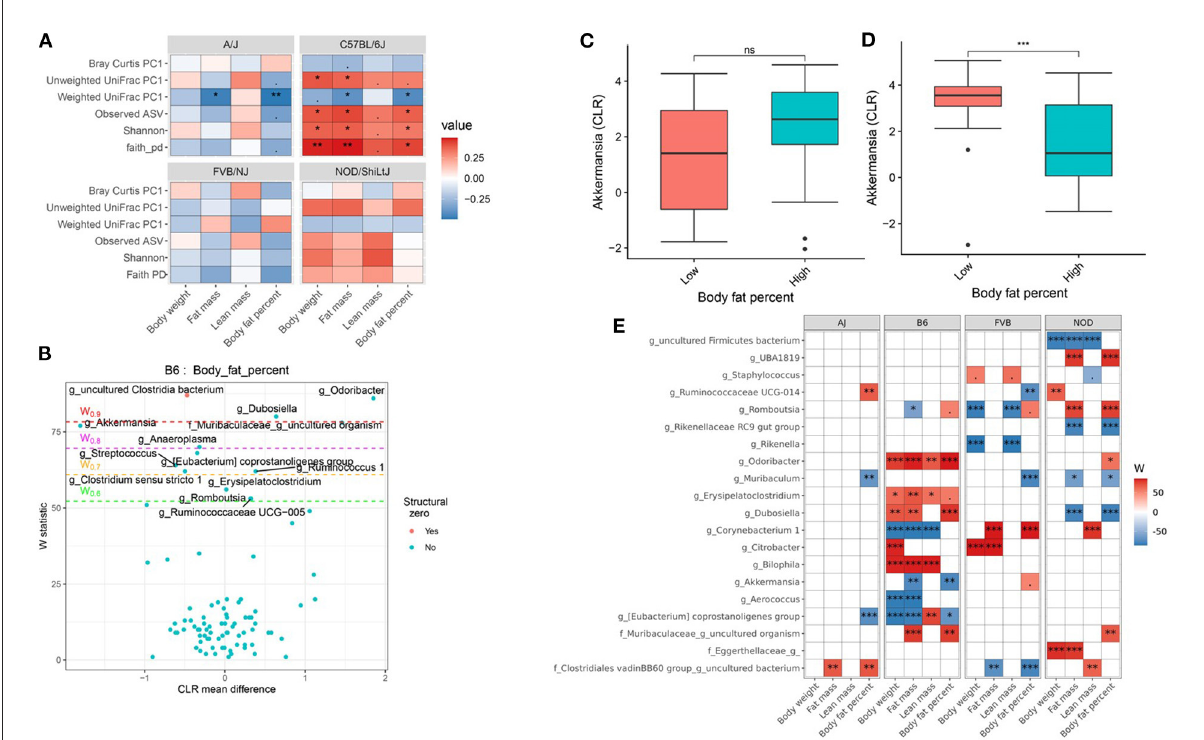
FIGURE5 Host genetics and gut microbiota interact to modulate host body composition. (A) Association between body composition measures and α -diversity or first principal component (PC1) of β -diversity measured by mouse strains determined by using Spearman correlation. As indicated, red represents a positive correlation and blue represents a negative correlation. “***” = adj. p < 0.001, “**” = adj. p < 0.01, “*” = adj. p < 0.05, “.” = adj. p < 0.10, and “ns” = not significant. (B) Volcano plot of the differential genera abundance between C57BL/6J mice with high (above median) and low (below median) body fat percentage determined by ANCOM analysis. Structural zero represents the presence of the bacteria in one group and complete absence in another group. (C) Relative abundance of the Akkermansia in A/J mice with high and low body fat percentage. (D) Relative abundance of the Akkermansia in C57BL/6J mice with high and low body fat percentage. Mean abundance was compared using the Wilcoxon rank-sum test. For (C,D) , “***” = P < 0.001 and “ns” = not significant. (E) Differential genera abundance between high (above median) and low (below median) body composition measures determined by ANCOM analysis. 20 most differentially abundant (based on cumulative ANCOM W-value) were selected for the graph. For easier presentation, ANCOM W values were converted to negative if CLR effect size is negative. Red indicates higher genera abundance in the above-median group and blue bacteria represents higher genera abundance in the below-median group. White represents a non-significant result obtained from ANCOM analysis. Models were adjusted for diet and sex as confounding factors. ANCOM models were FDR (BH-method) corrected for multiple comparisons and a significant sub-hypothesis test at a level of adj. P < 0.05 was counted toward W-value. The median was calculated for each mouse strain. For (E) , “***” = ≥ W 0.9 , “**” = ≥ W 0.8 , “*” = ≥ W 0.7 , and “.” = ≥ W 0.6